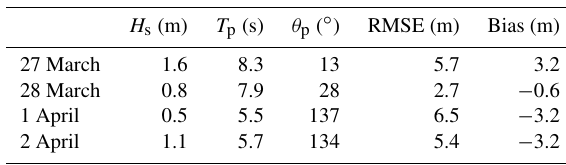
Table 4. Dates and forcing conditions of the SWASH simulations and results of the validation against observed shoreline position in the Cala Millor beach.